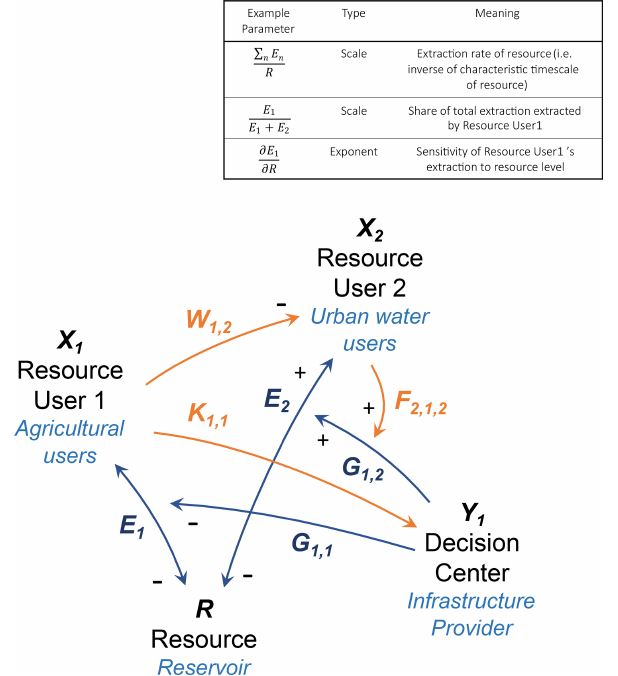
Figure 1. Example system diagram. The nodes ( R , X 1 , X 2 , and Y 1 ) are the state variables in the model, while the linkages repre- sent functions (in blue) or parameters (orange) describing how the variables interact. In this example water governance system, there are two types of water users, agricultural users and urban users, withdrawing water from a reservoir. The governance intervention G 1 , 1 in this example can be interpreted as infrastructure managed by the infrastructure provider, or decision center, that delivers wa- ter to the city, supporting urban extraction while reducing agricul- tural extraction. The orange linkages represent possible Nash equi- librium strategies that may result from this setup. In this example, urban users allocate all of their effort to supporting the infrastruc- ture that allows for their extraction ( F 2 , 1 , 2 ), while agricultural users split their effort between undermining the organizational capacity of urban users ( W 1 , 2 ) and of the decision center ( K 1 , 1